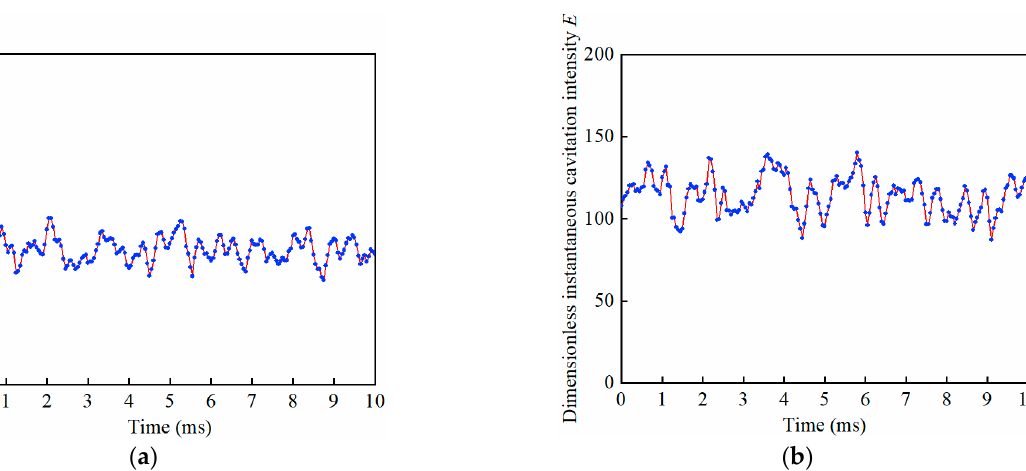
Figure 8. Dimensionless instantaneous cavitation intensity obtained by image processing: ( a ) at a working pressure of 10 MPa; ( b ) at a working pressure of 15 MPa.